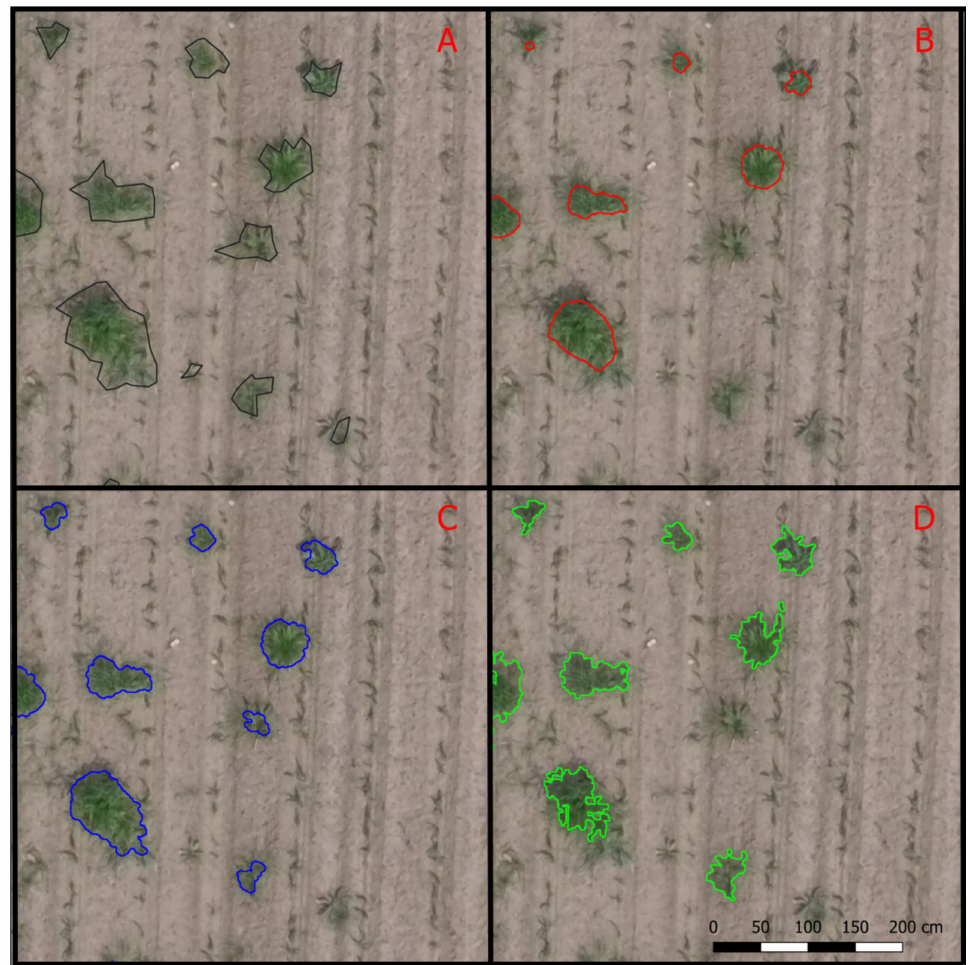
Figure 7. Detail of the weed maps obtained with: ( A ) photointerpretation (reference data), ( B ) the MLC method, ( C ) ANN method, ( D ) and OBIA